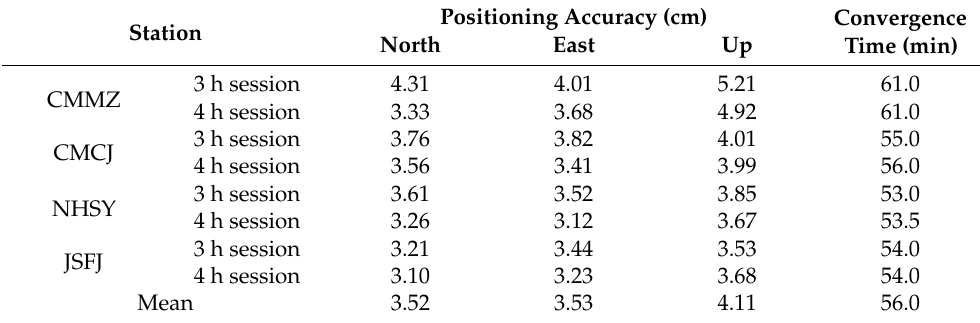
Table 2. Positioning accuracy and convergence time.